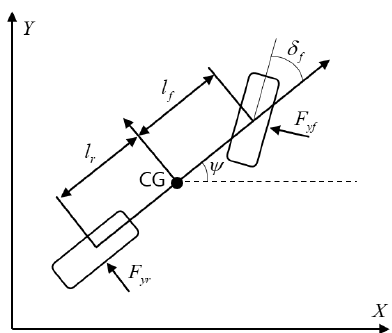
Figure 8. Vehicle bicycle model for path